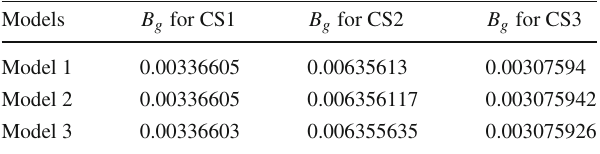
Table 2 The approximate values of the constant B g for the three dif- ferent stars under three different models Models B g for CS1 B g for